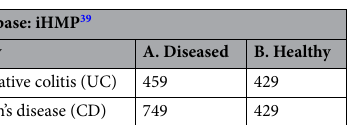
Table 2. Three real data sets were used in this study. We analyzed samples from Ulcerative colitis (UC), Crohn’s disease (CD), and healthy individuals (non-IBD). The number of samples from CD is relatively higher than the